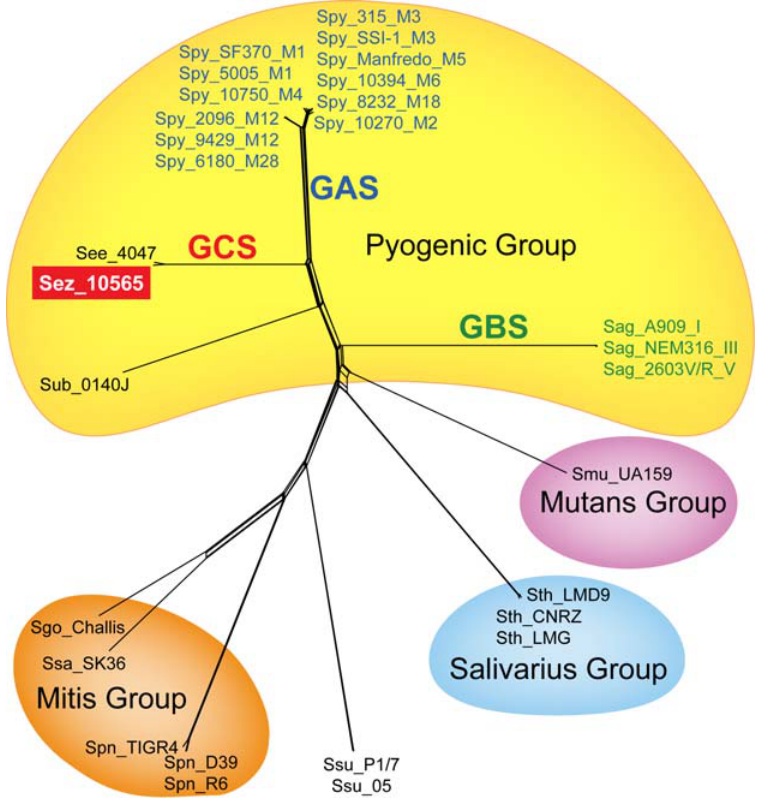
Figure 2. Streptococcal multilocus genetic relationships. Inferred sequences of the DNA replication and repair proteins DnaA, DnaE, DnaG, DnaI, DnaJ, DnaN, and DnaX were concatenated, aligned and used to infer genetic relationships among the streptococcal strains for which complete genome sequences are available. The genes encoding these proteins are conserved genus-wide and arrayed around the chromosome.